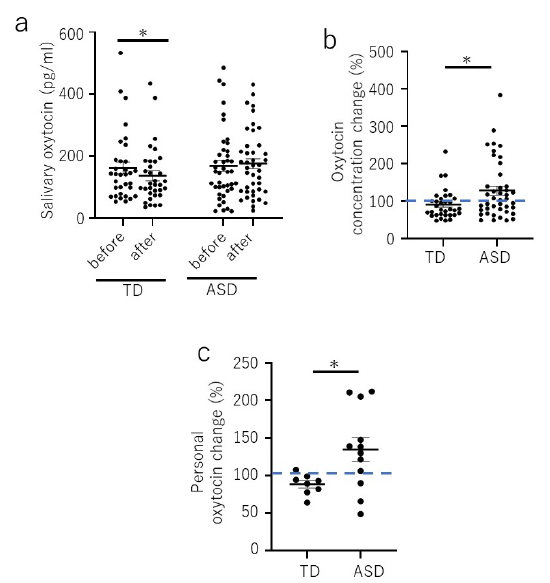
Figure 1. The salivary oxytocin levels before and after participatory art workshops. ( a ). Salivary oxytocin level before and after each session in the typically developed (TD) children and those with autism spectrum disorder (ASD). Note that not all children attended all five sessions of the art workshop (total number of sessions analyzed: 33 for the TD children and 42 for the children with ASD). ( b ). Percentage of salivary oxytocin in the TD children and those with ASD after each session. Note that not all children attended all five sessions of the art workshop (total number of sessions analyzed—33 for the TD children and 42 for the children with ASD). ( c ). Personal average percentage of salivary oxytocin level after each session in the TD and ASD groups (number of children assessed: TD, n = 8; ASD, n = 12). Data are mean ± sem. * p < 0.05.